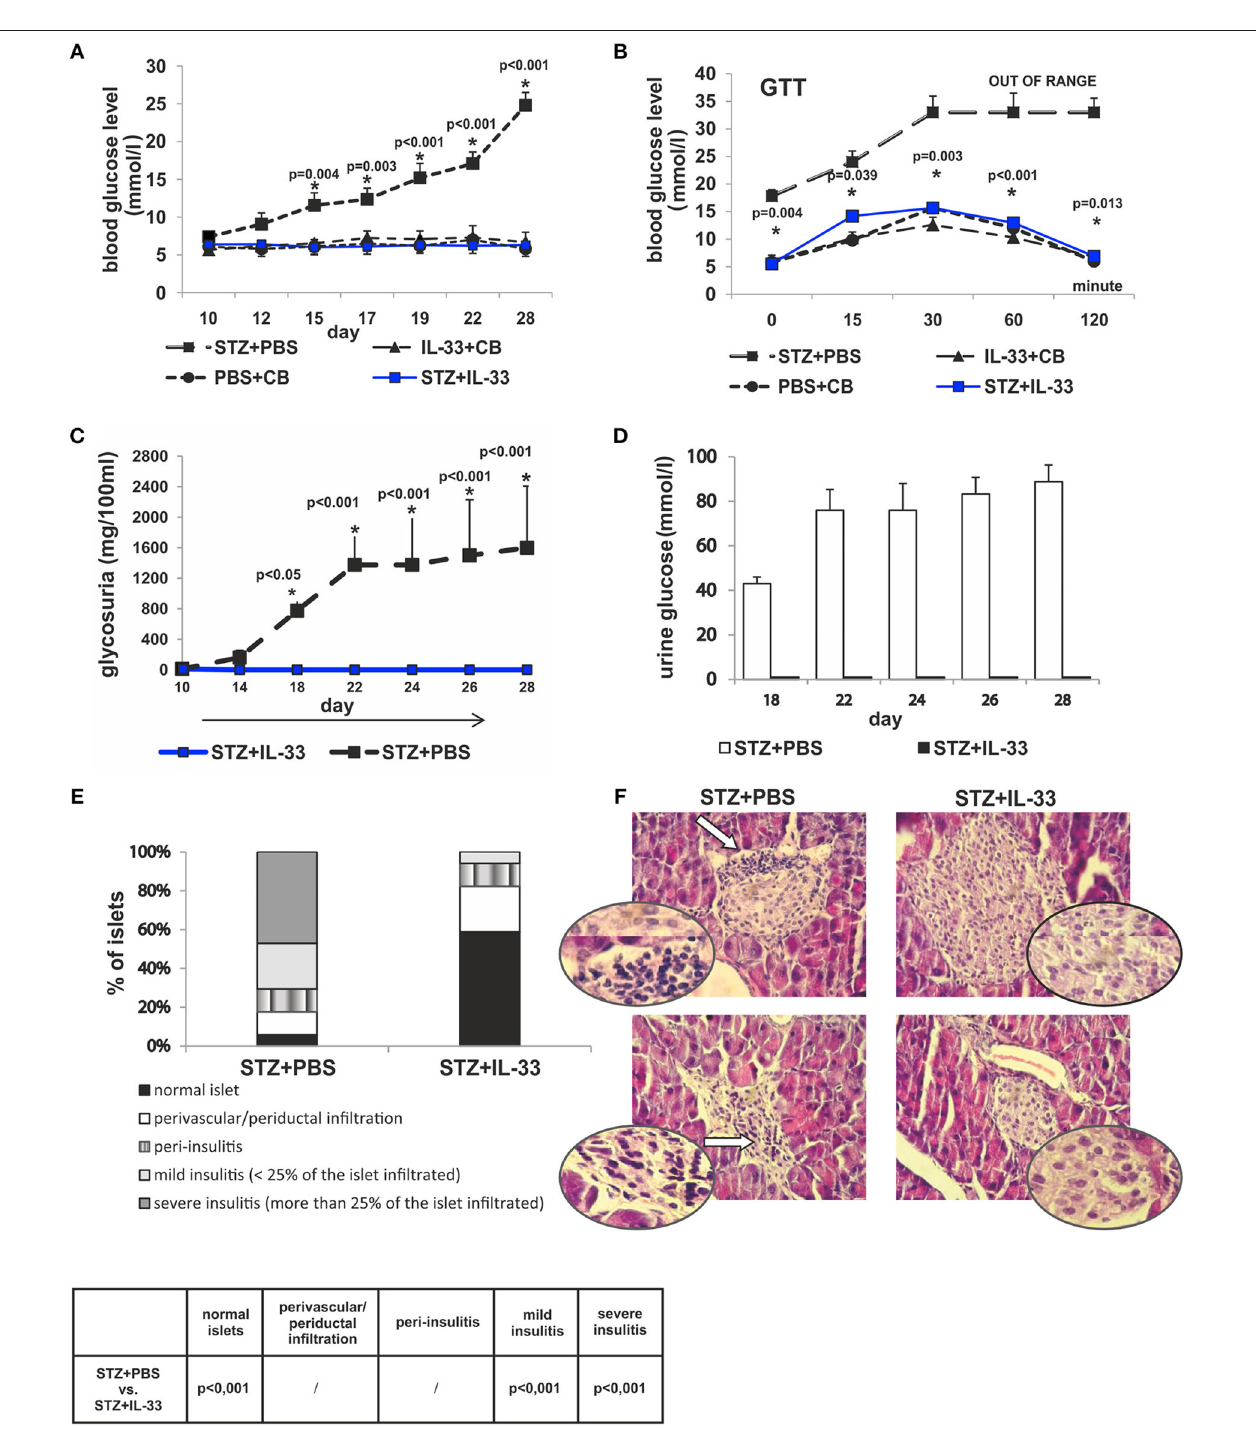
FIGURE 1 | Concomitant treatment with recombinant IL-33 completely abrogates induction of diabetes by MLD-STZ. Effect of four injections of 0.4 µ g/mouse IL-33 on glycemia (A) , GTT test (B), and glycosuria (C,D) . Histology of the islets showed highly significant ( p < 0.001) decrease of mononuclear cells influx in IL-33 treated group compared to control group (E,F). An analysis of lymphocytic infiltrates in Langerhans’s pancreatic islands was performed by light microscope using a magnifying lens of 40 X.